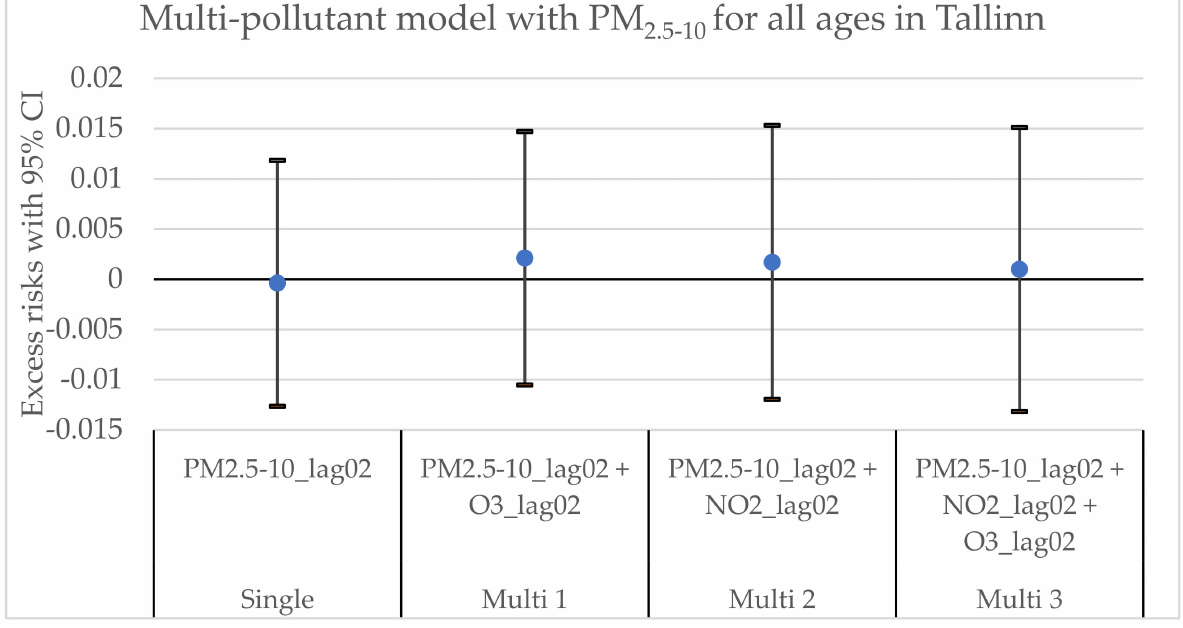
Figure A6. Multi-pollutant models of the estimated change in daily mortality in all ages (with 95% CI) for an IQR increase in the concentration of PM 2.5–10 (lag02) in Tallinn. From left to right: a single-pollutant estimate of PM 2.5–10 (Single), PM 2.5–10 adjusted for O 3 (Multi 1), PM 2.5–10 adjusted for NO 2 (Multi 2), and PM 2.5–10 adjusted for both NO 2 and O 3 (Multi 3).